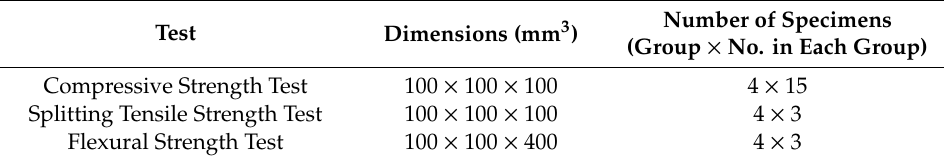
Table 4. Details of the tests and